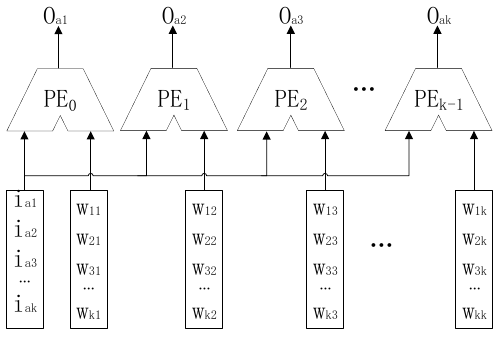
Figure 7. Realization of matrix multiplication based on vector SIMD technology.